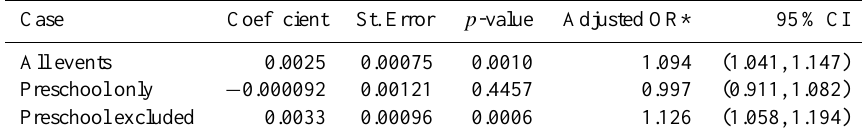
Table 3. Case-crossover statistics relating asthma incidents to PM 10 concentrations in Phoenix